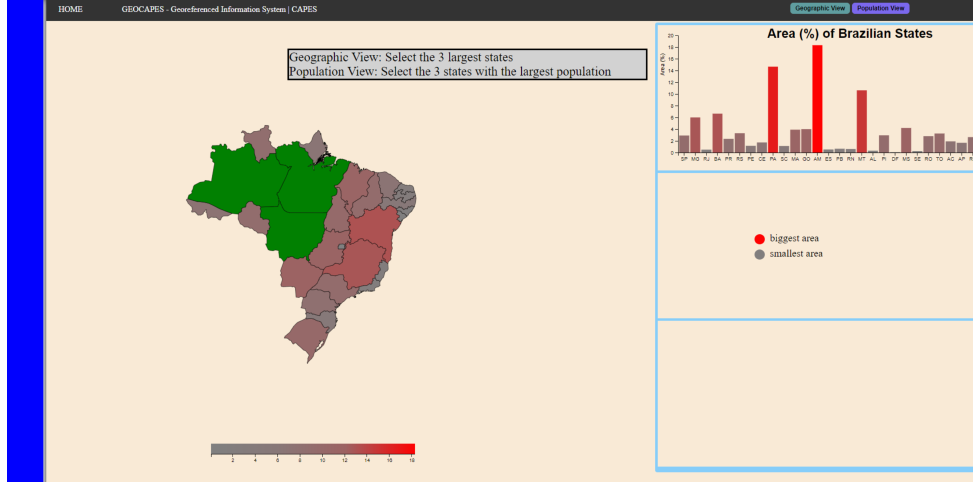
Figure 7. Final state of the first task step in scenario 1.